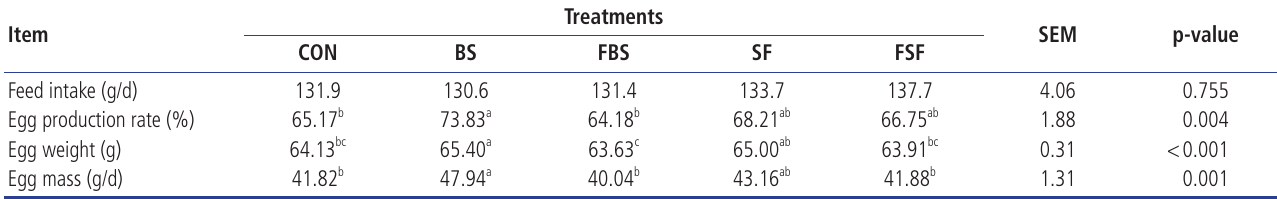
Table 3. Effects of dietary supplementation with non-fermented or fermented by-products of brown seaweed and seaweed fusiforme on laying performance in laying hens Item